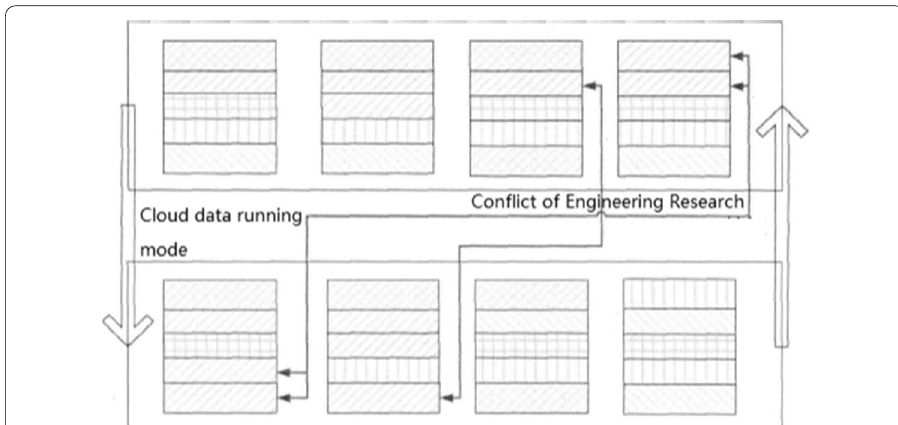
Fig. 2 Operation method of conflict analysis for cloud data engineering research